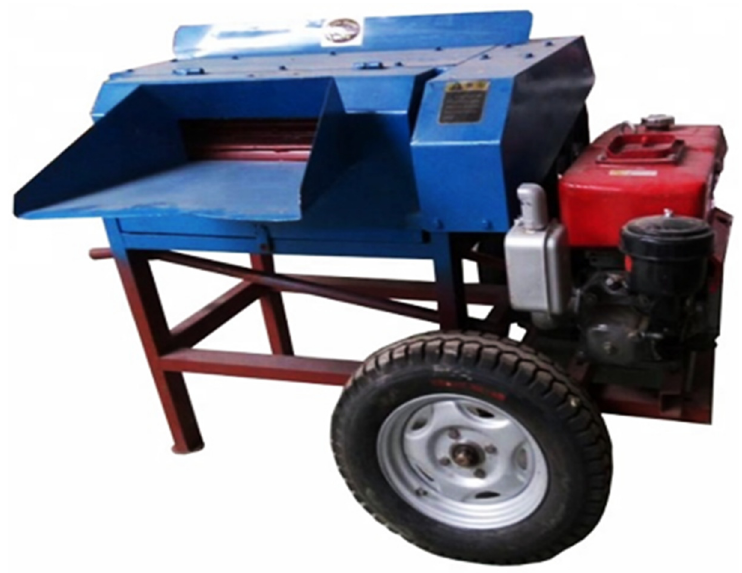
Figure 1. Pictorial view of the jute fiber extraction machine of the KP model. Table 1. Technical parameters of the jute fiber extraction machine of the KP model. Feeding System